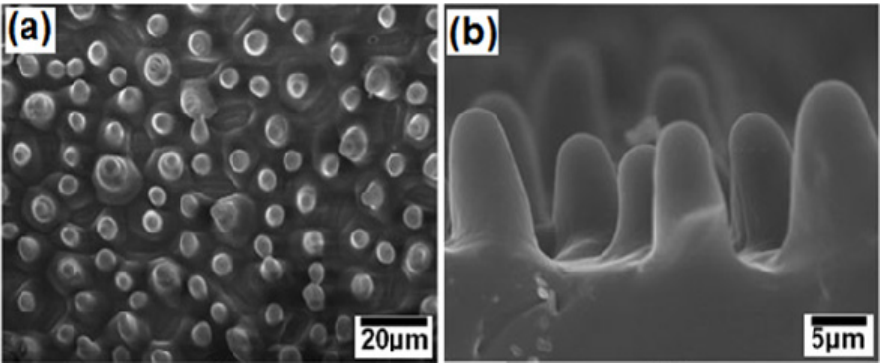
Figure 8. SEM images of the imprinted layers of epoxy-based azo polymer ( a ) a top-view and ( b ) a cross-section view of the surface. Images reprinted from [80], with permission from WILEY-VCH Verlag GmbH & Co. KGaA, Weinheim, Copyright